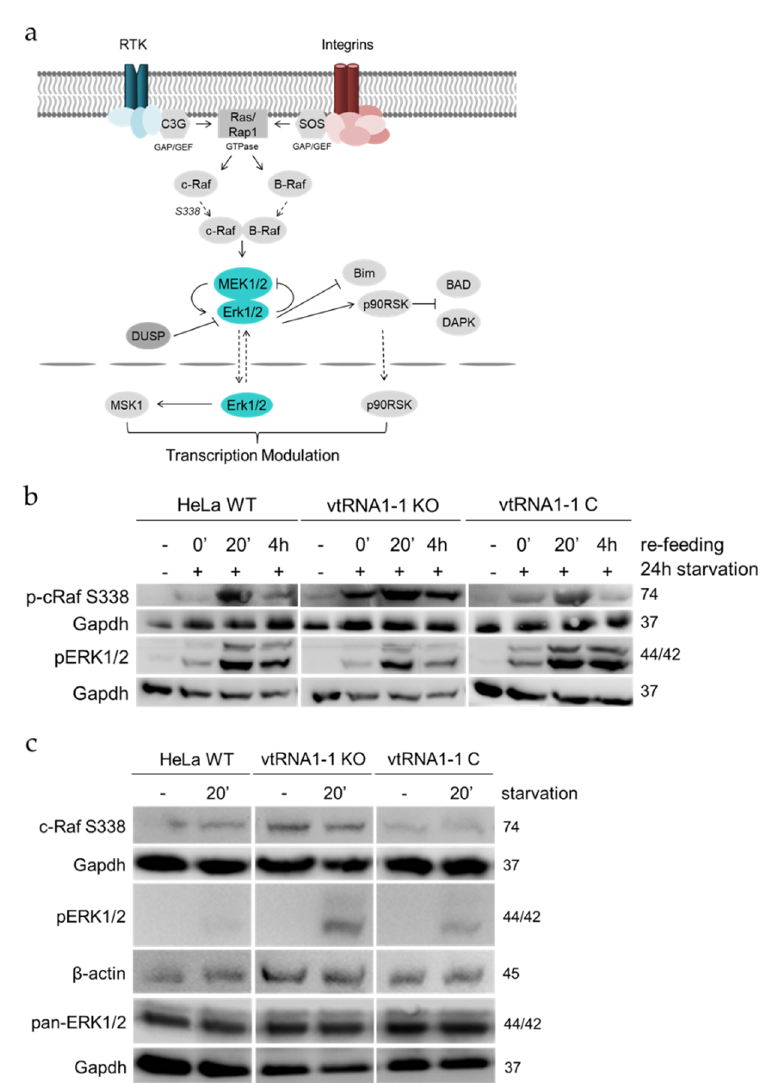
Figure 5. The initiation of the ERK1/2 MAPK cascade in starvation-induced HeLa cells is vtRNA1-1 dependent. ( a ) Simplified schematic representation of the ERK1/2 MAPK signaling cascade. The two kinases ERK1 and ERK2 are the major signal transducers. MEK1/2 represent the MAPKK and c-Raf represents the MAPKKK. ( b ) Western blot analysis was used to assay the levels and the kinetics of PAK1 phosphorylated c-Raf (S338) and phosphorylated ERK1/2 as a result of 24 h serum deprivation with chloroquine followed by re-feeding. Gapdh served as loading control. ( c ) Phospho-protein levels of the ERK1/2 cascade involved proteins c-Raf and ERK1/2 were assessed in the absence of starvation (−) or following 20 min of starvation with chloroquine (20’). Gapdh and β-actin served as loading controls.